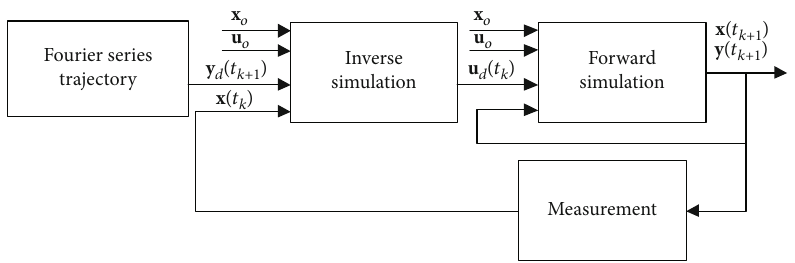
Figure 3: On-line control loop under the inverse simulation